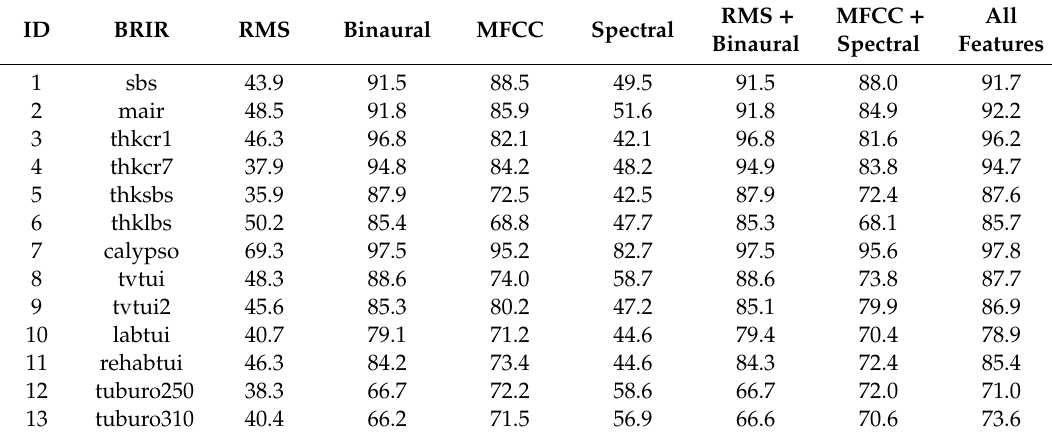
Table 5. Training accuracy (%) of the models obtained using subsets of recordings synthesized with individual BRIR sets. Each training subset included 336 audio excerpts.